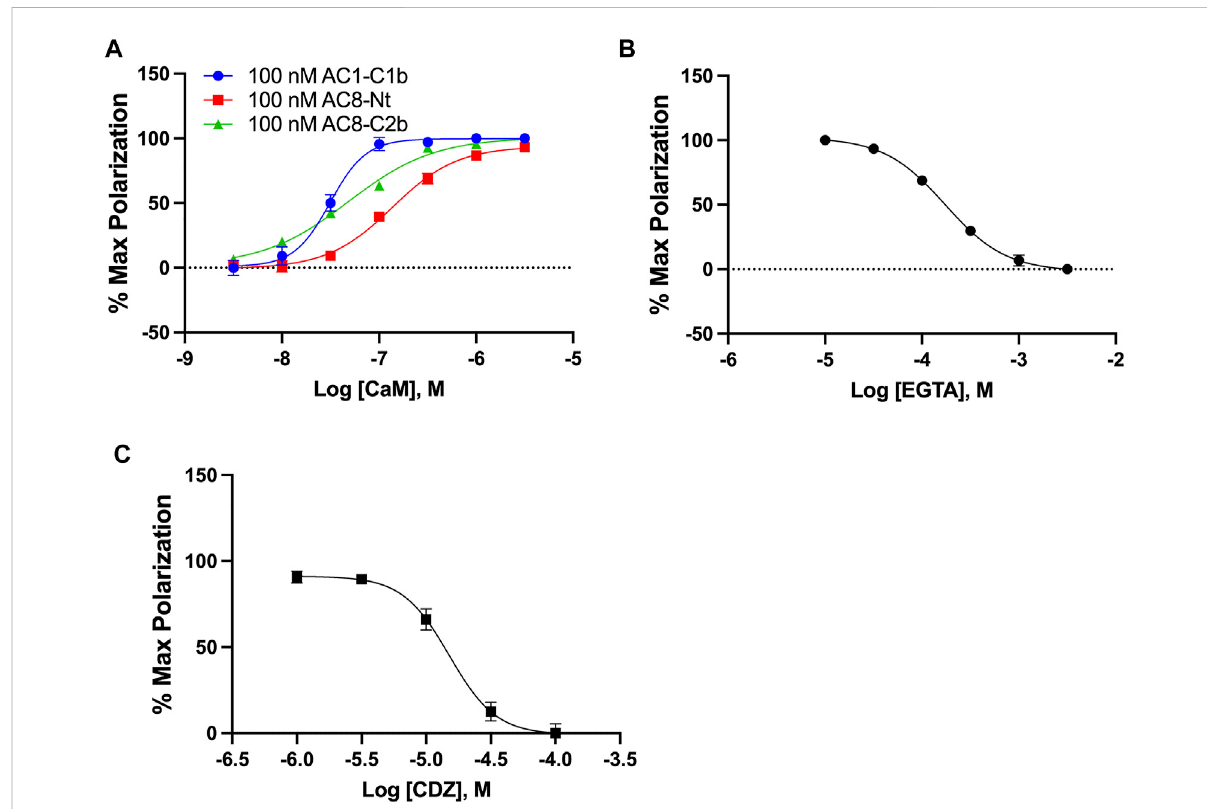
FIGURE 1 AC1/CaM FP Assay development. (A) 100 nM AC1-C1b (Blue), AC8-NT (Red), or AC8-C2b (Green) peptide with increasing concentrations of GST-CaM. Saturation is reached at ~100 nM GST-CaM. (B) 100 nM AC1 peptide and 100 nM GST-CaM with increasing concentrations of EGTA. (C) CRC for CDZ with 100 nM AC1-C1b and 100 nM GST-CaM, with 1% DMSO in the buffer. The AC1/CaM IC 50 value for CDZ was ~15 μ M and the IC 90 was ~100 μ M, which was used in the fi nal assay. Calmidazolium CAS number: 57265 – 65 – 3. All data represents n = 3 experiments